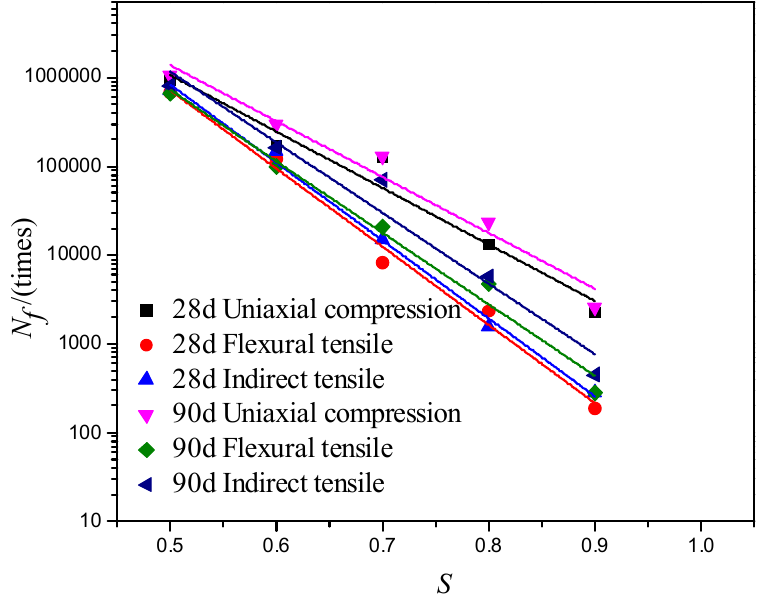
Figure 6. Fitting curve for the fatigue equation for a cement content of 3% under different stress states.